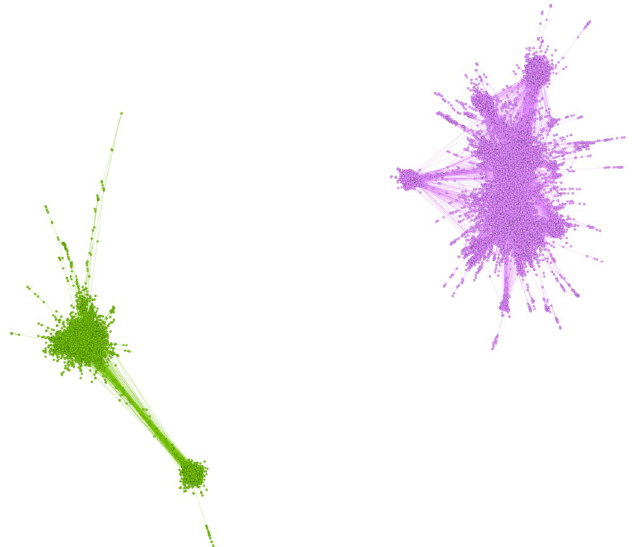
Fig 5. The reciprocal subgraph of the retweet network of the election for the whole time of data gathering.